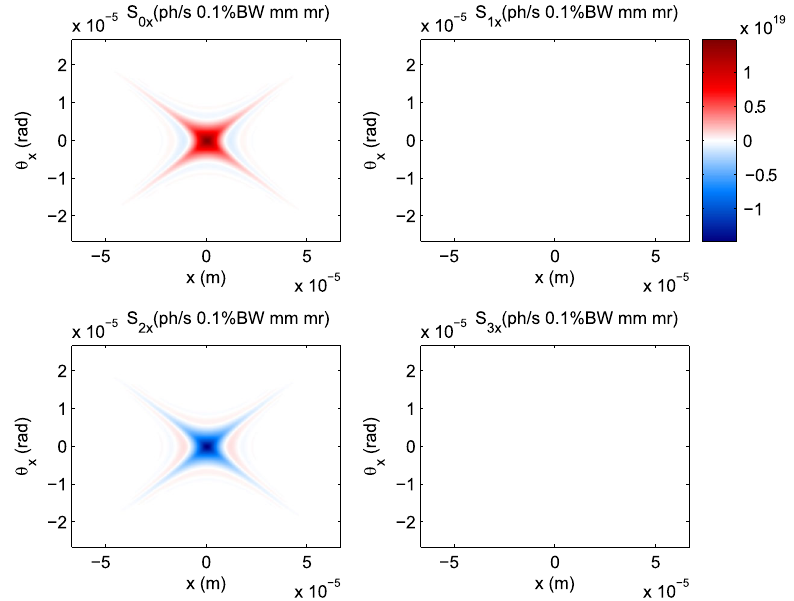
FIG. 11. Wigner-Stokes density distribution functions computed for a helical undulator. The x-ray phase space is backpropagated to the undulator center. Refer to the text for